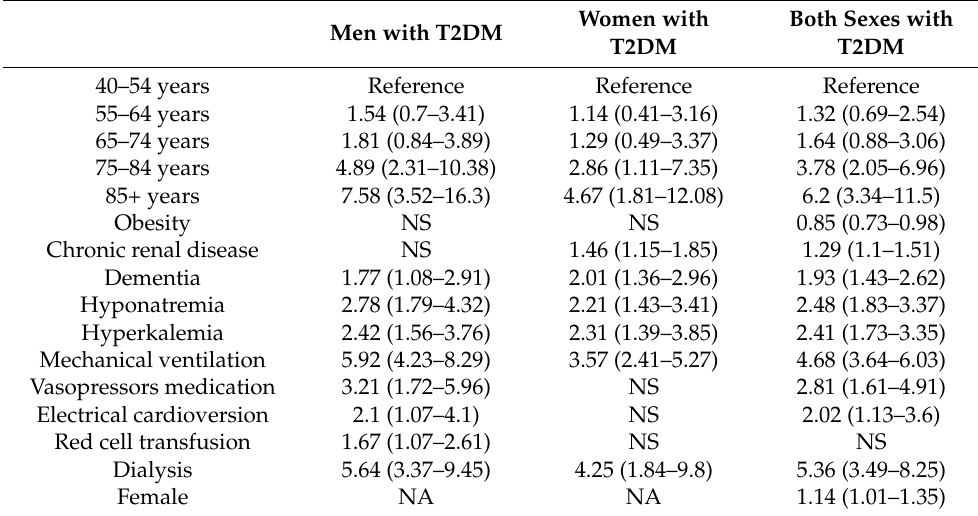
Table 5. Variables independently associated with in-hospital mortality among men and women with type 2 diabetes mellitus hospitalized with systolic heart failure in Spain from 2016 to